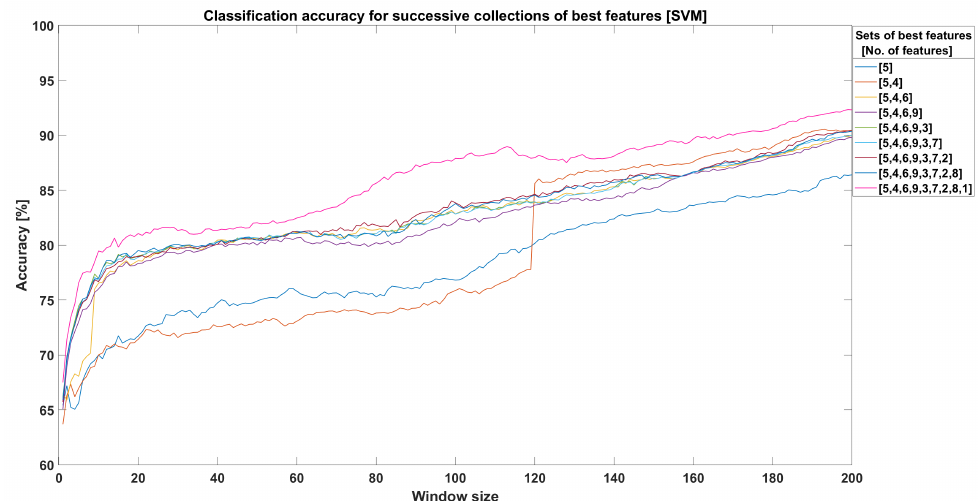
Figure 10. Classification accuracy for successive collections of best features [Random Forest].